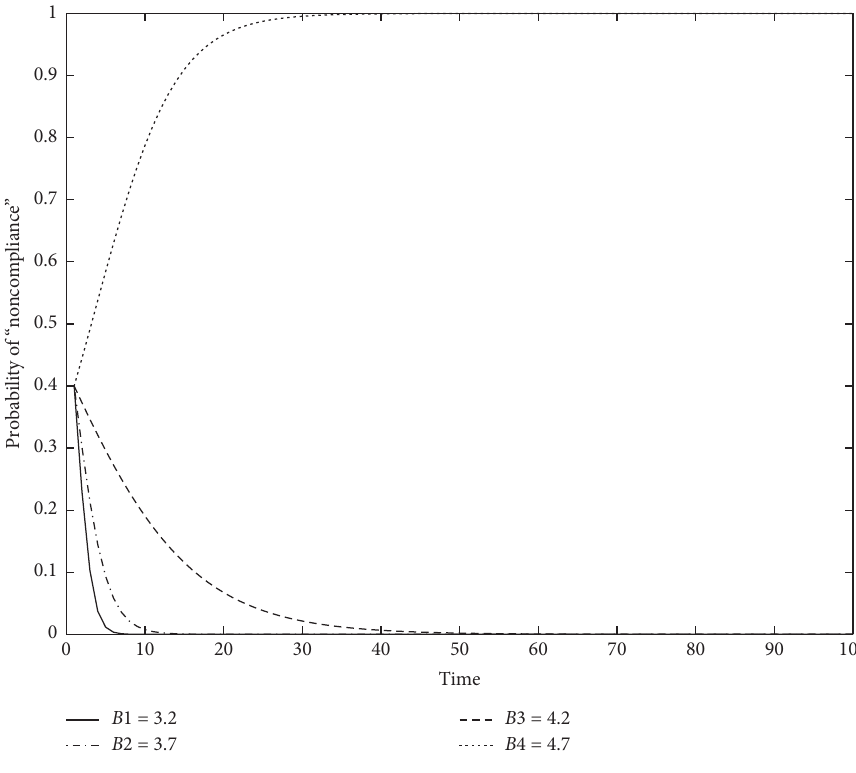
G and profit losses